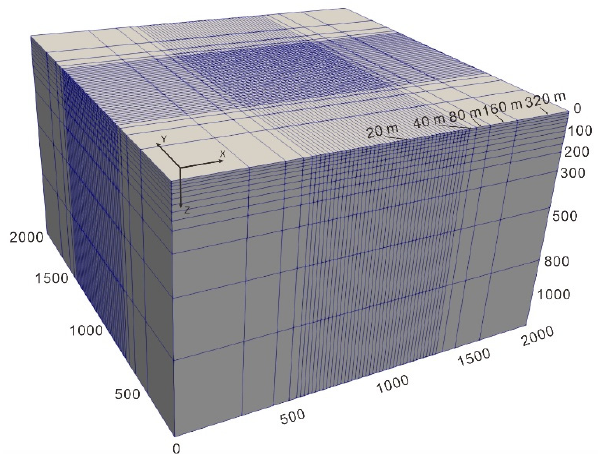
Figure A2. Model grids for synthetic examples. (The air layer is not included).